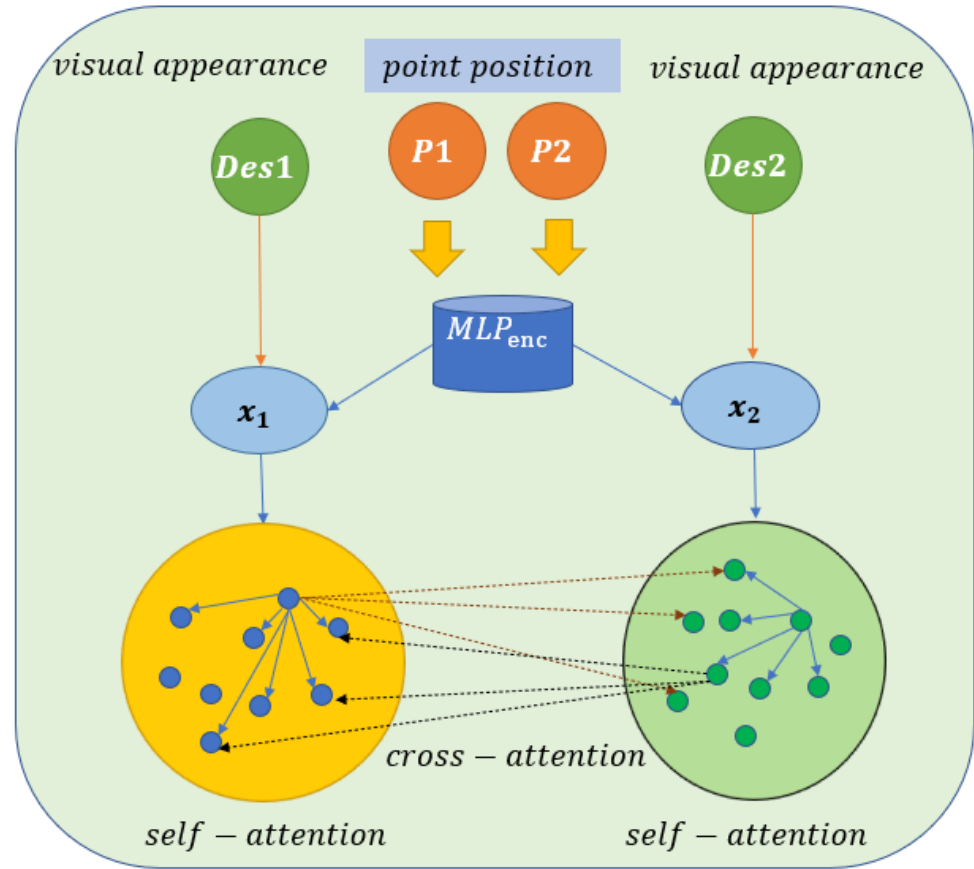
Figure 4. Attentional Graph neural network(adapted from ref. [8]).